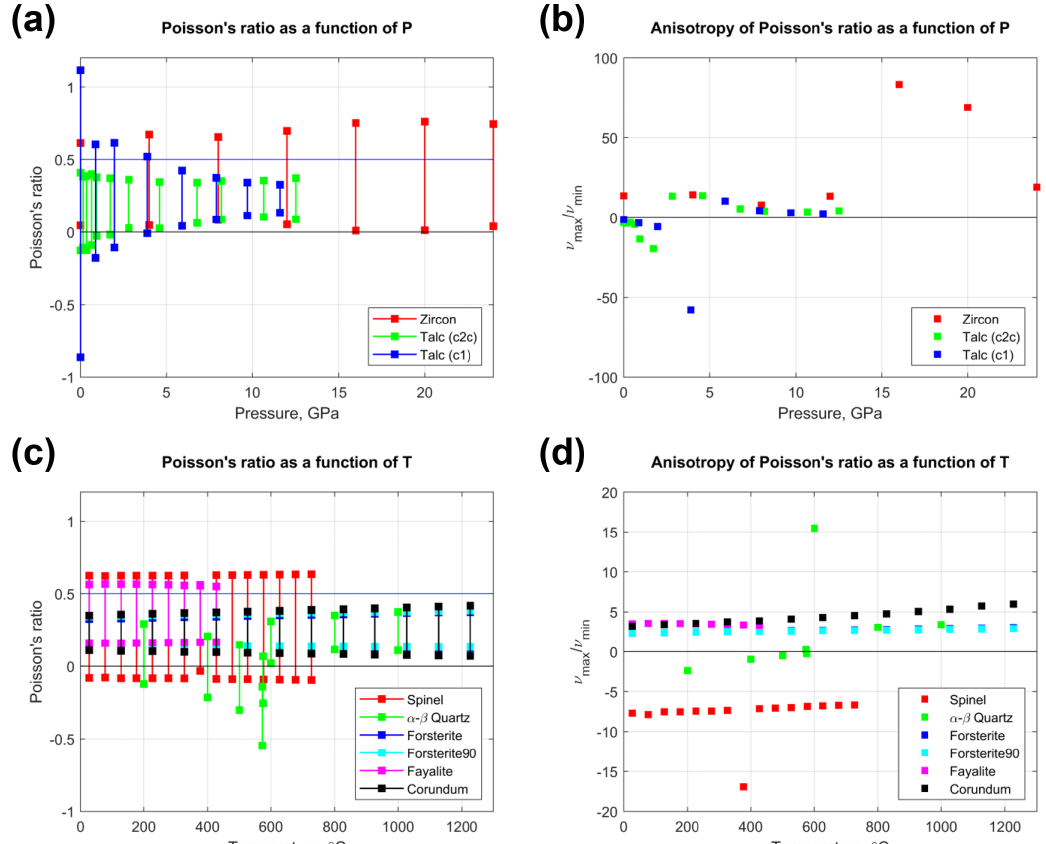
Figure 14. Anisotropy of Poisson’s ratio in rock-forming minerals as a function of P (a, b) and T (c, d) . Other than the well-known auxeticity of α – β quartz around the phase transition ( T = 573 ◦ C), most minerals display Poisson’s ratios of between 0 and 0.5. Talc (c1, triclinic) is one exception, and the anisotropy of Poisson’s ratio decreases markedly with increasing P .